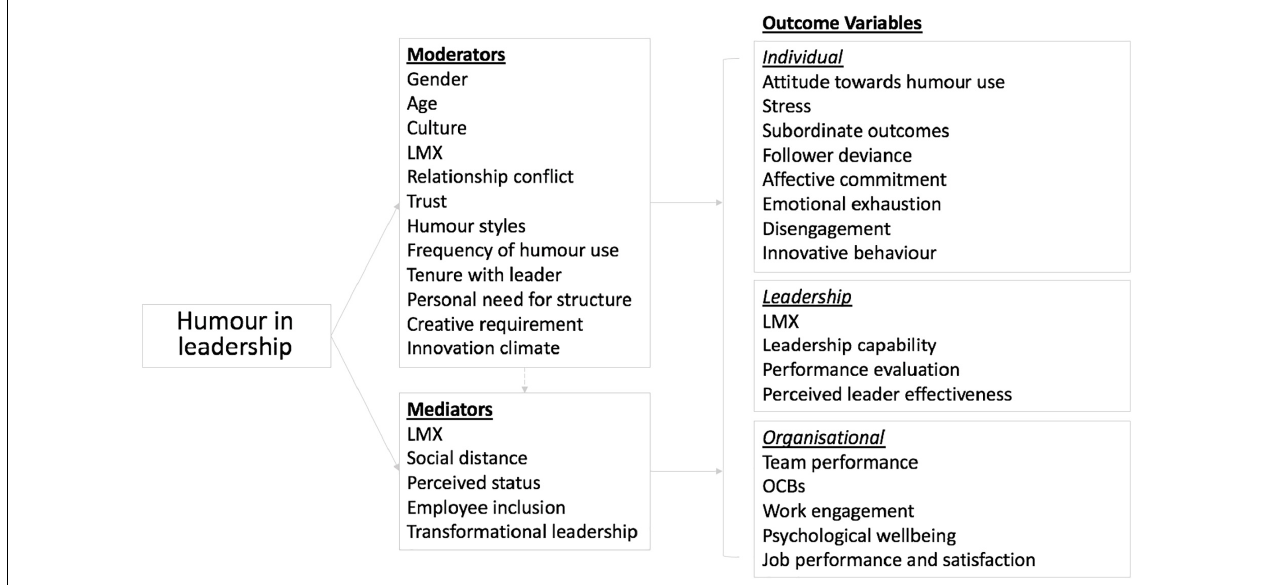
FIGURE 4 | An illustrated summary of the effects of humor used in leadership in terms of individual, leadership, and organizational outcomes with associated moderators and mediators.